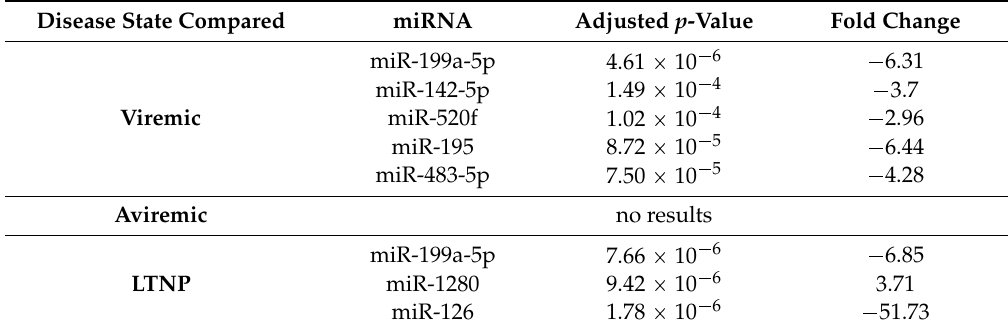
Figure 7. Venn diagram of DE miRNA in CD4+ T-cells when disease groups are compared to HIV– controls. FDR method was used. This diagram shows the lack of results for aviremic samples and overlapping expression of one miRNA; miR-199a-5p. Table 3. DE miRNAs in CD4+ T-cell disease groups compared to HIV– controls. Disease State Compared